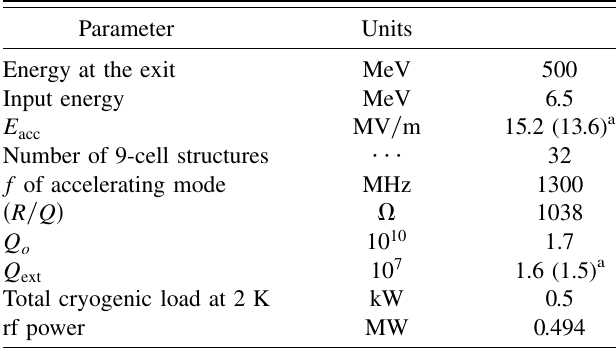
TABLE IV. Parameters of the first part of the linac. Parameter